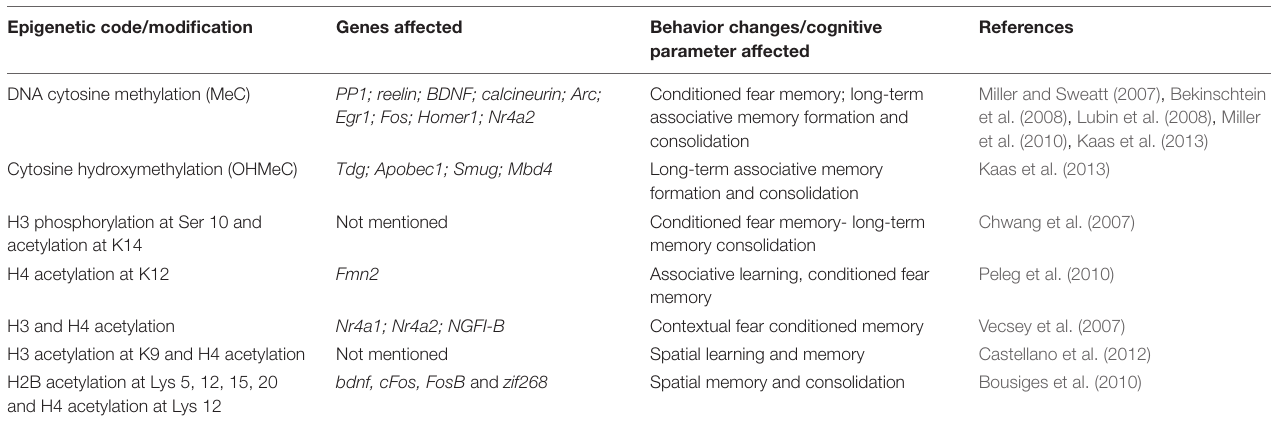
TABLE 3 | Prominent behavior changes in aging and underlying epigenetic